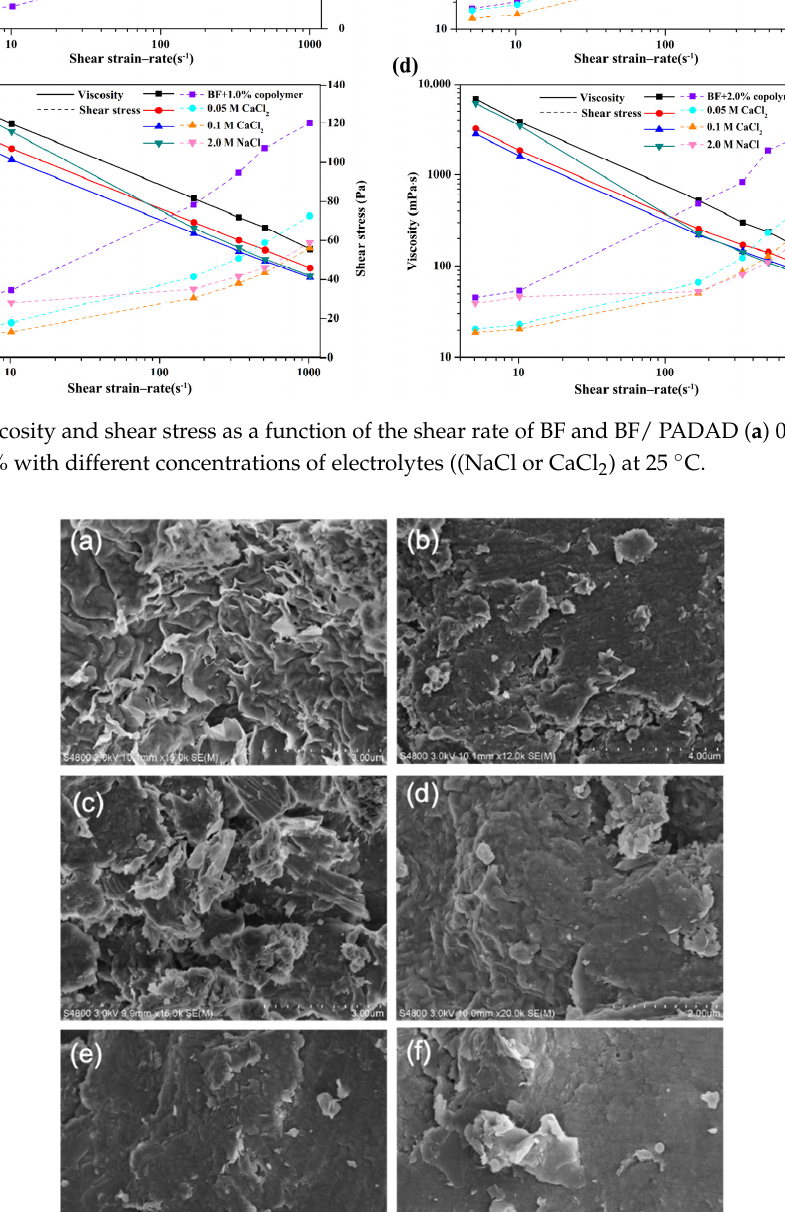
Polymers 2021 , 13 , x 10 of 16